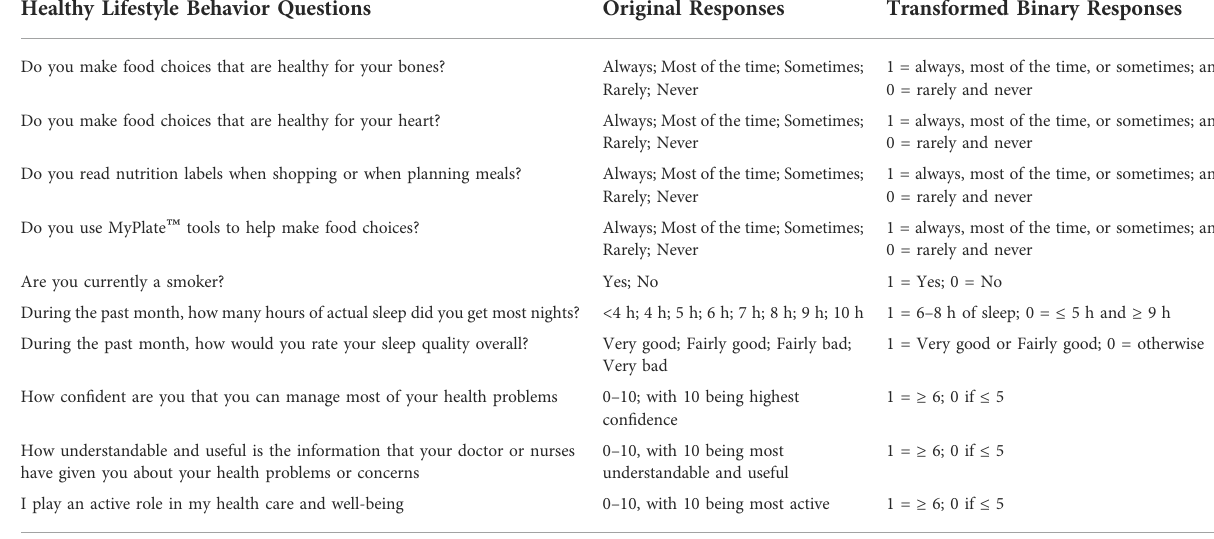
TABLE 2 Healthy lifestyle behavior questions (transformed to binary